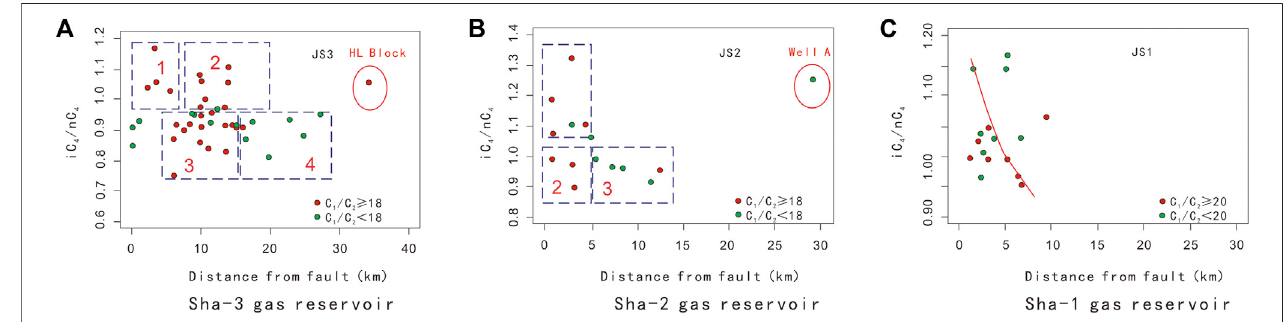
FIGURE 6 | Intersection of natural gas iC 4 /nC 4 values and distance from fault in the Shaximiao Formation reservoir, Zhongjiang gas fi eld.